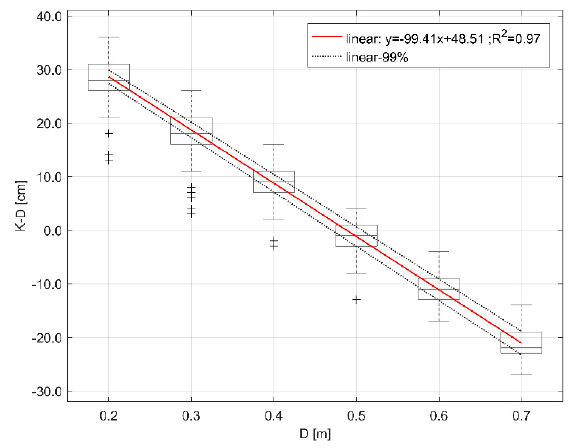
Figure 2. Database characterization depending on K-D versus the tested D values. The boxplot graph includes possible outliers (shown by “+”). The linear regression and the 99% boundaries are shown.